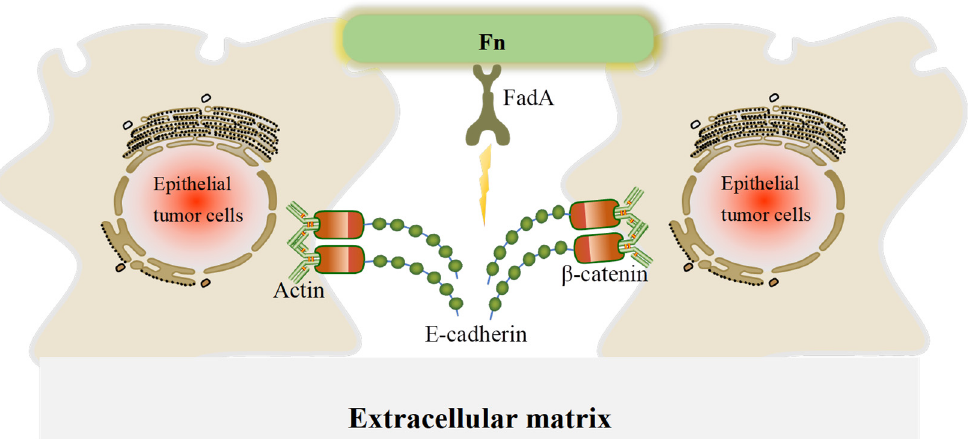
Figure 3. A schematic of the effect of FadA in disrupting adherence junctions in CRC cells. In adherence junctions, E-cadherin and β -catenin form complexes on epithelial cell membranes and bind to the actin cytoskeleton to maintain cell–cell adhesion. When FadA invades, it can bind to E-cadherin, resulting in its separation from β -catenin and subsequent activation of β -catenin signaling, leading to a reduction in cell–cell adherence between cancer cells.